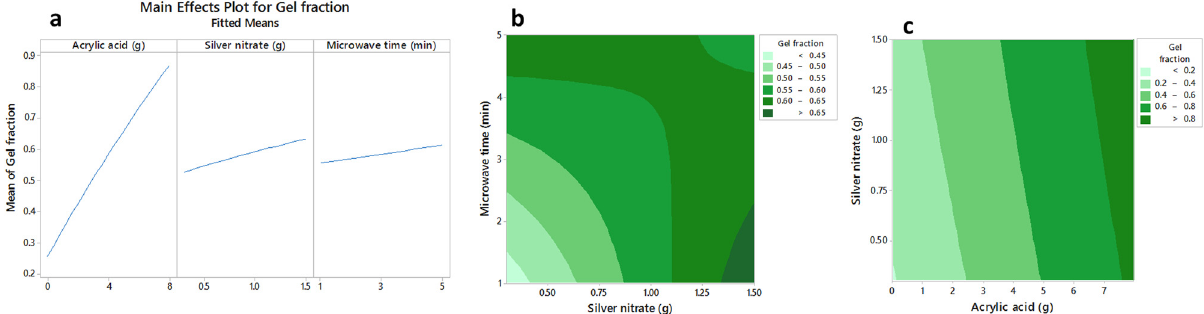
Figure 2: The main e ff ects plot ( a ) and the contour plots ( b and c ) of acrylate acid, silver nitrate and microwave time on gel fraction of sodium alginate/acrylic acid composite hydrogels conjugated to silver nanoparticles.